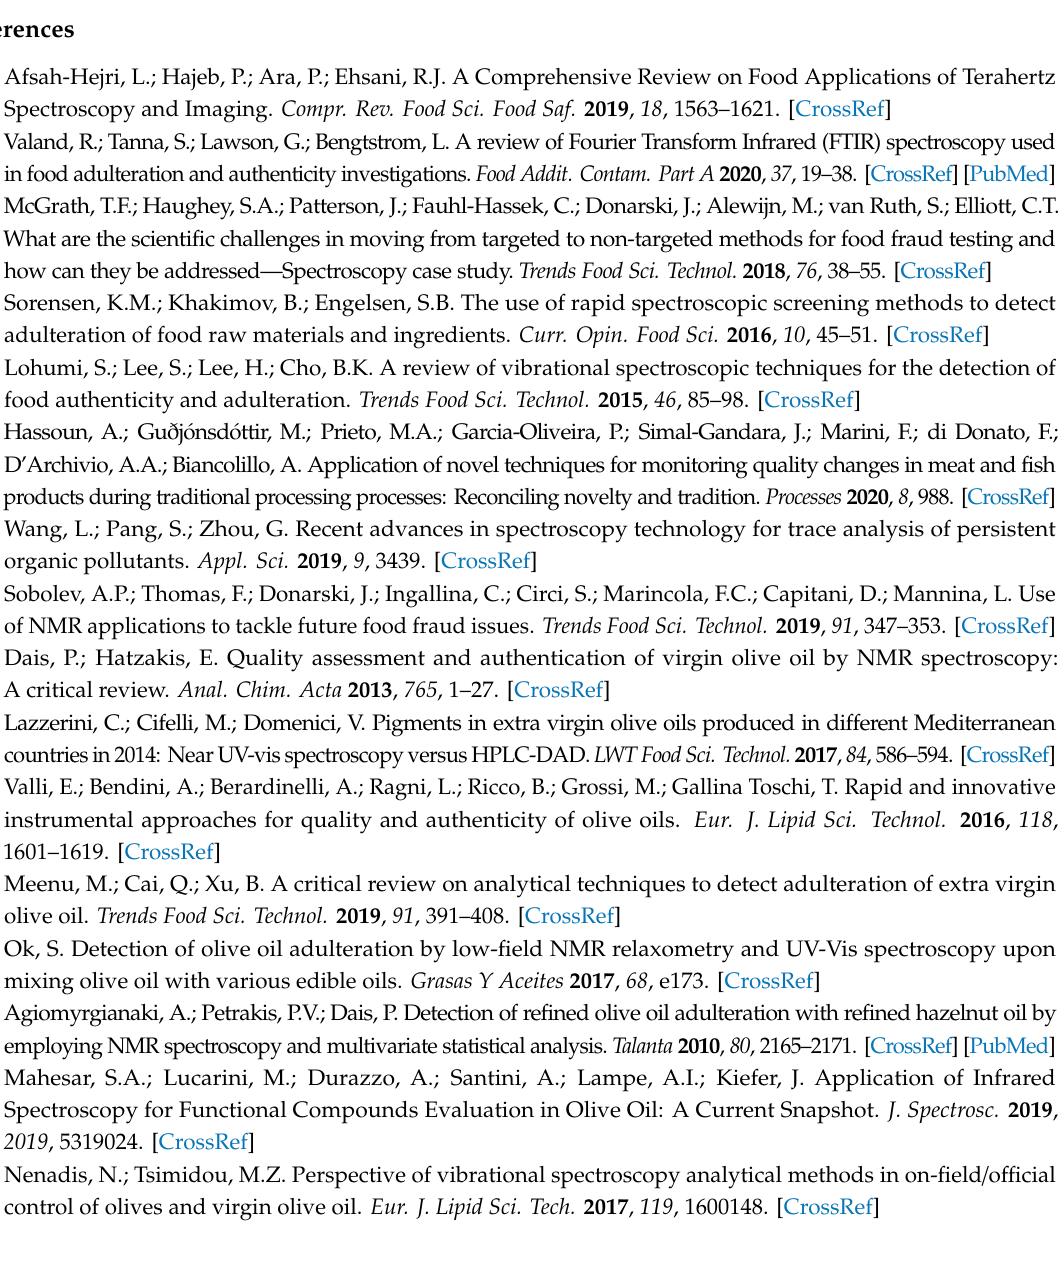
work. Figure S1: Shows a selection of 1 H NMR spectra recorded in bulk (diacylglycerols signals) on the three EVOO